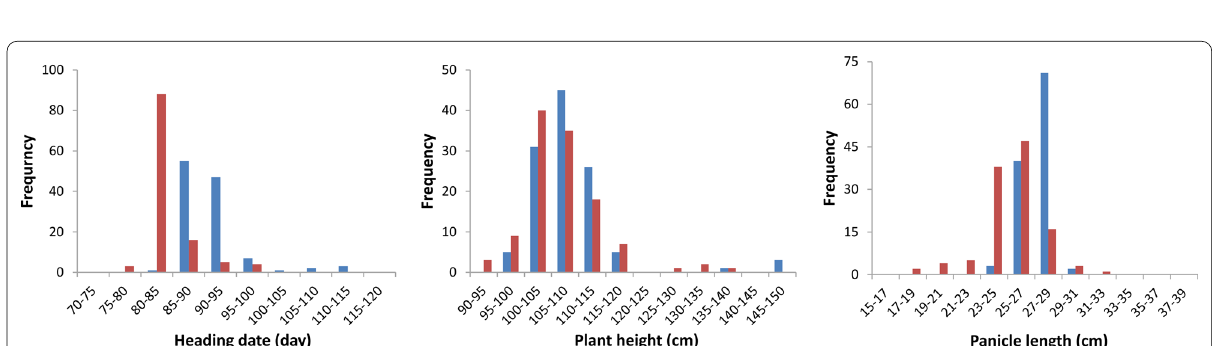
Fig. 4 Frequency distributions of the three traits in the CSSLs. The blue and orange rectangles represent the distribution of the three traits in the CSSLs at the Shanghai and Hangzhou locations, respectively. The vertical axis of each figure represents the number of CSSL